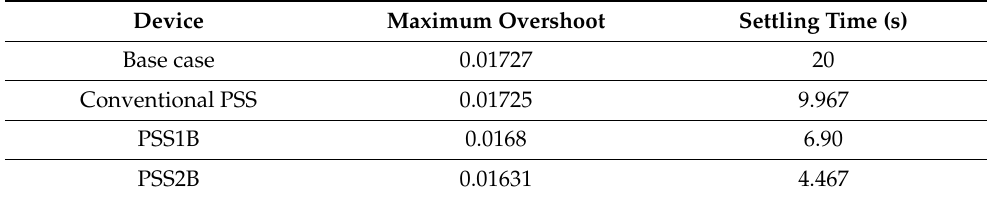
Table 18. Maximum overshoot and settling time of rotor speed deviation at light loading.